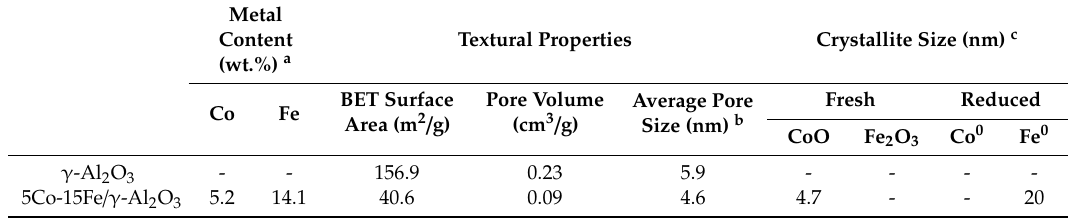
Table 1. Characterization of γ -Al 2 O 3 support material and FT catalyst (5Co-15Fe / γ -Al 2 O 3 ).